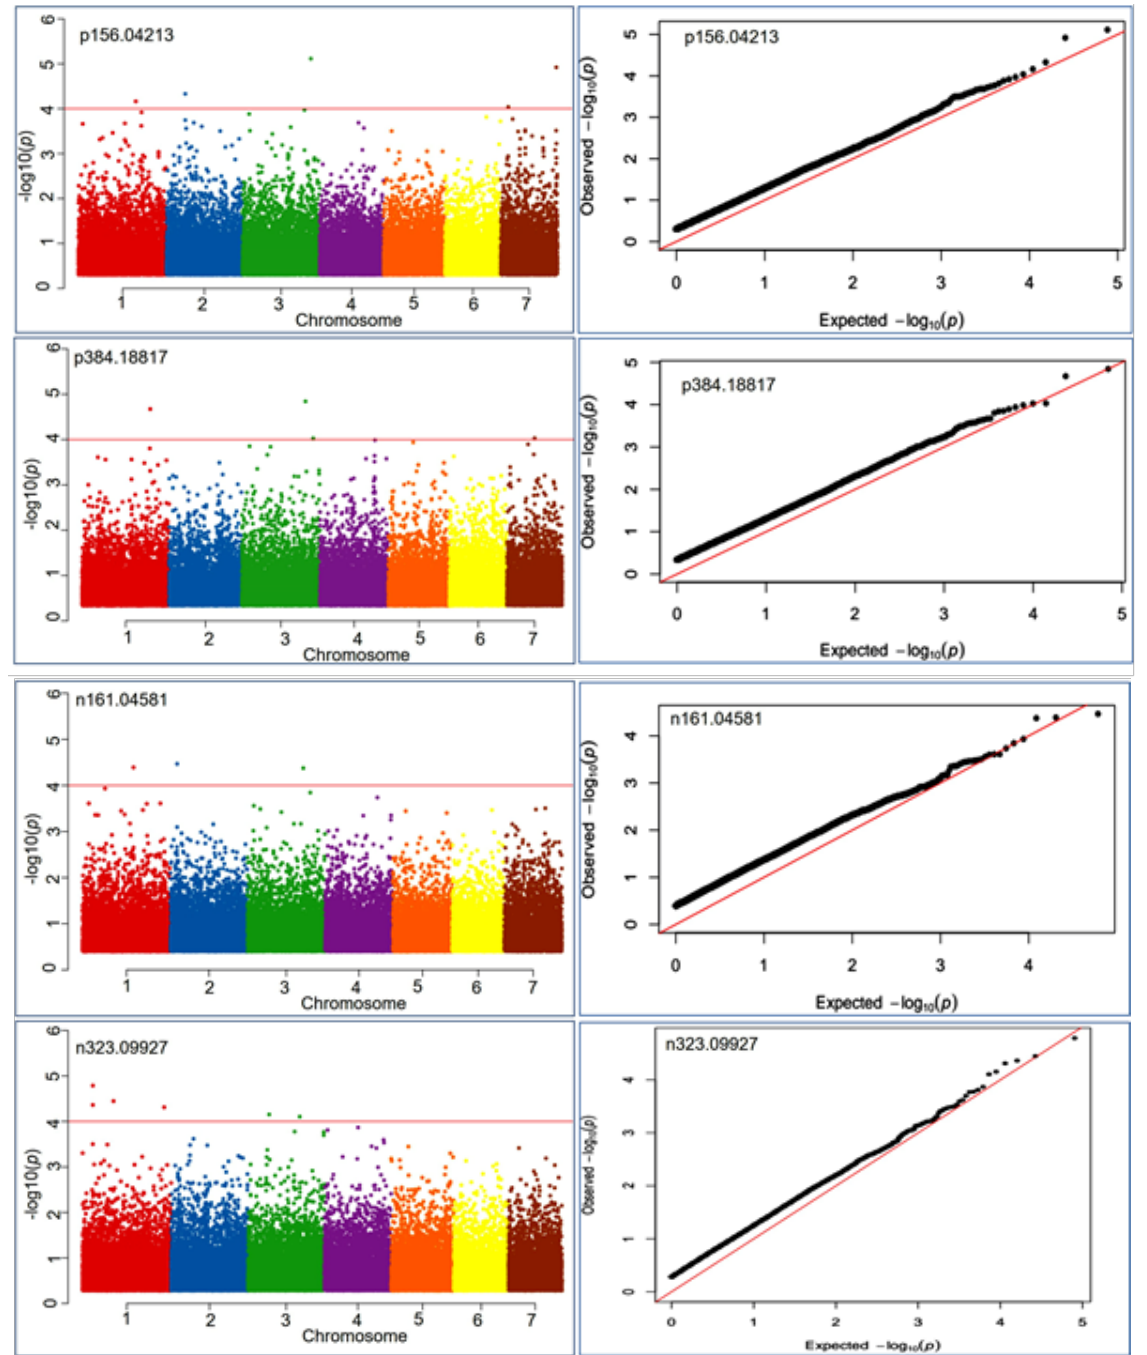
Figure 4. Manhattan and QQ plots exhibiting significantly associated SNP markers based on p -values measured by MLM model during metabolic genome-wide association studies (mGWAS) for four representative mass features p156.04213 involved in anthocyanin and lipid metabolism, p384.18817 involved in vitamins metabolism, n161.04581 involved in vitamins and starch metabolism, n323.09927 involved in starch and sucrose